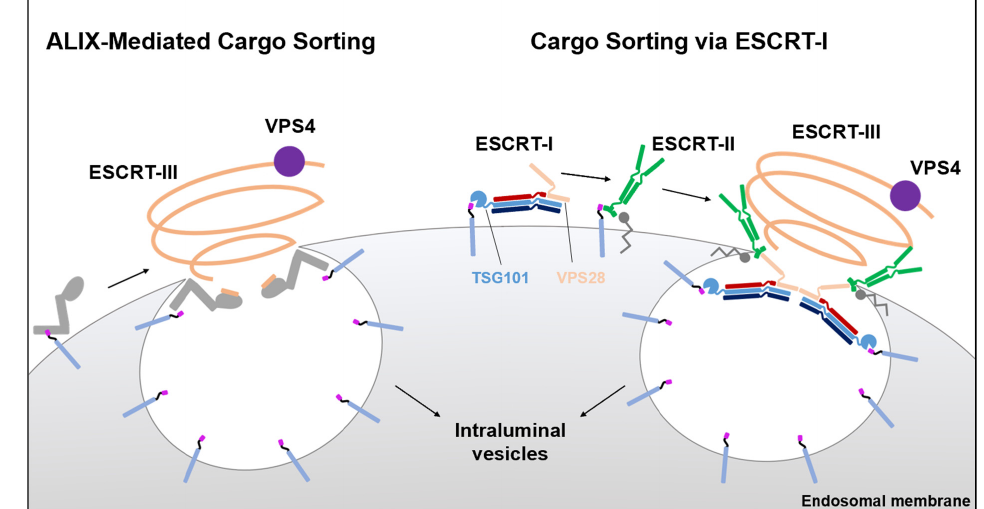
Figure 1. The respective roles of ALIX and ESCRT-I in the sorting of membranous cargo. Upon internalization, ubiquitylated cargo is detected by ALIX ( left ) and ESCRT-I ( right ) for compartmen- talization into intraluminal vesicles that are destined for degradation via the late endosome. Both ALIX and ESCRT-I contain ubiquitin binding domains that facilitate this first step. Unlike ESCRT-I, ALIX possesses an ESCRT-III binding domain that allows for the direct recruitment of ESCRT-III and VPS4, the machinery required for sealing of cargo within intraluminal vesicles and abscising these vesicles from the endosomal membrane. In a similar fashion, the ESCRT-I component TSG101 binds ubiquitylated cargo, while the VPS28 component can recruit ESCRT-III through ESCRT-II which also binds ubiquitylated cargo as well as phospho-inositol